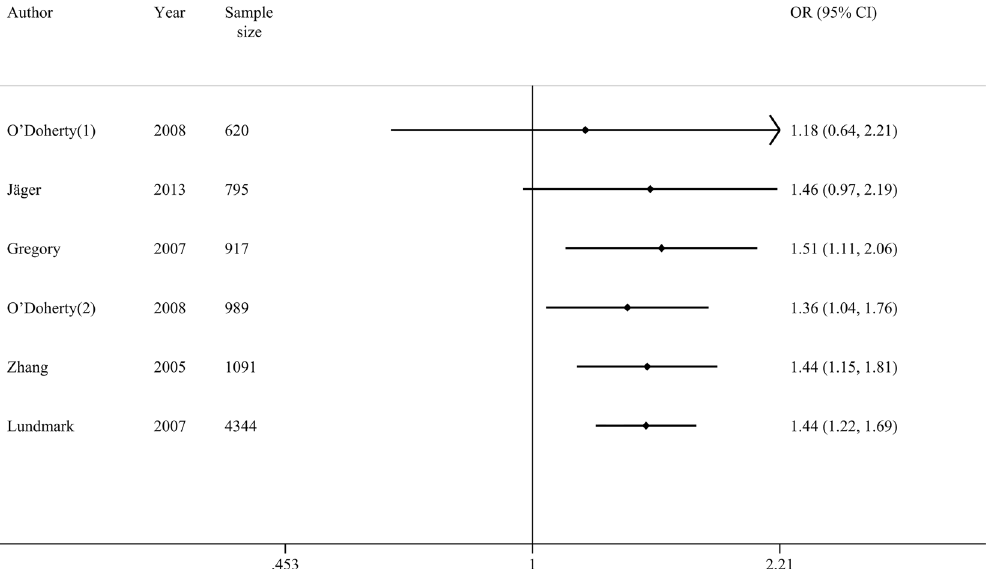
risk.). The Egger’s test also did not display any evidence of obvious publication bias for the association of these SNPs with MS risk (Table 4).